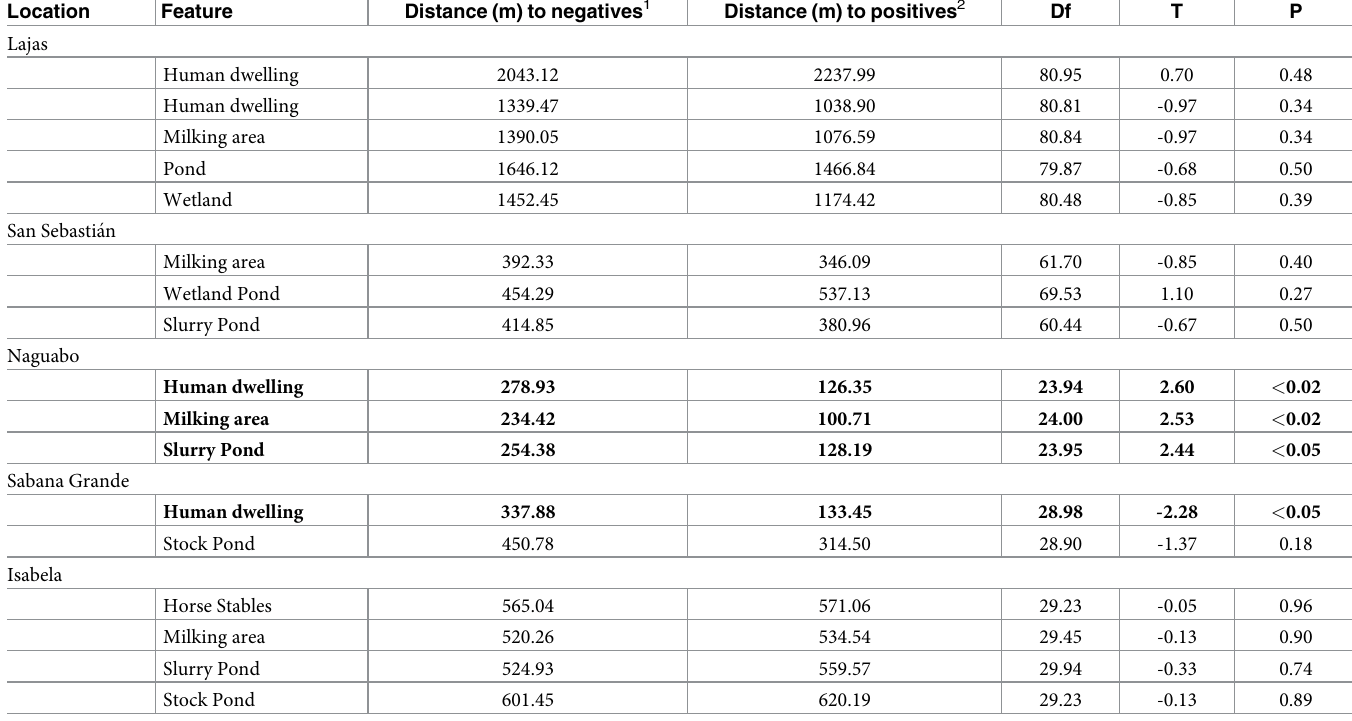
Table 3. Correlation of landscape features present on individual farms in Puerto Rico to Leptospira prevalence among host species collected from five farms in Puerto Rico during summers 2014 and 2015. Host species included Rattus rattus , R . norvegicus , Mus musculus , and Herpestes auropunctatus . Distances between host spe- cies and selected landscape features were calculated from GPS coordinates using the haversine equation. Welch’s t-tests were used to determine if the average distance of positive samples to the landscape features were closer than the average distance of negative samples using an aloha value of 0.05. Significant results are denoted in bold.